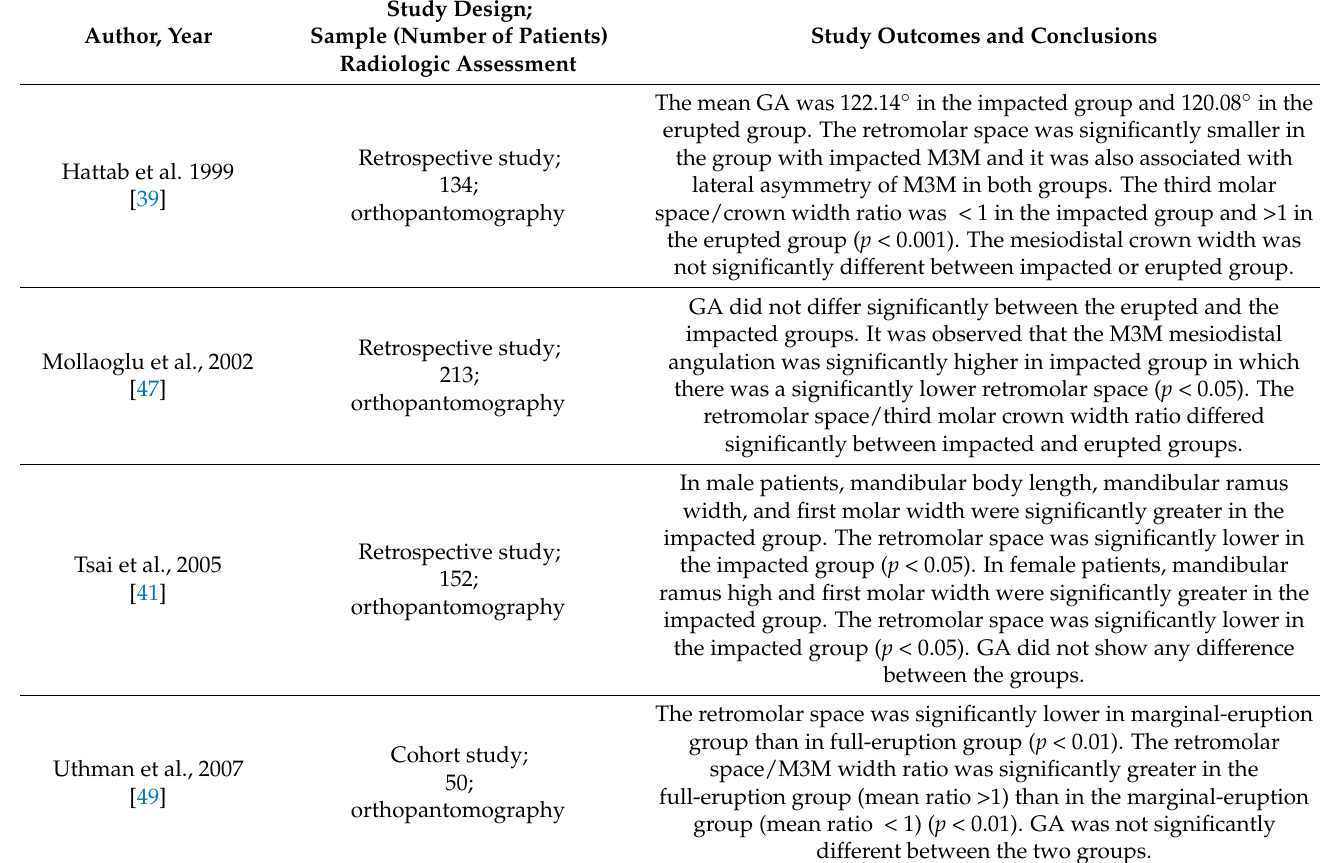
Table 5. Literature review of the studies investigating the correlation between mandibular morphology and third molar